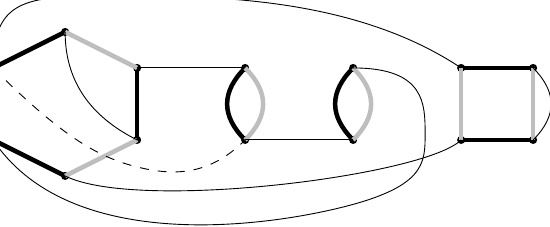
Figure 3 . The example graph G along with a perfect matching P (thin black lines) so that P [ A is a cycle.